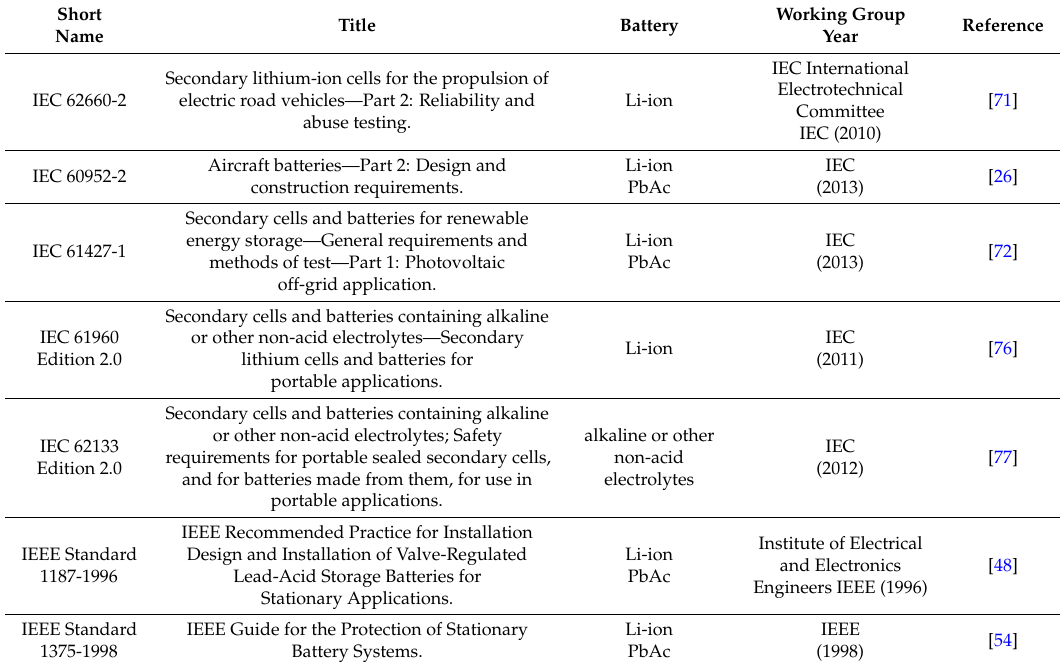
Table 3. Existing standards regarding